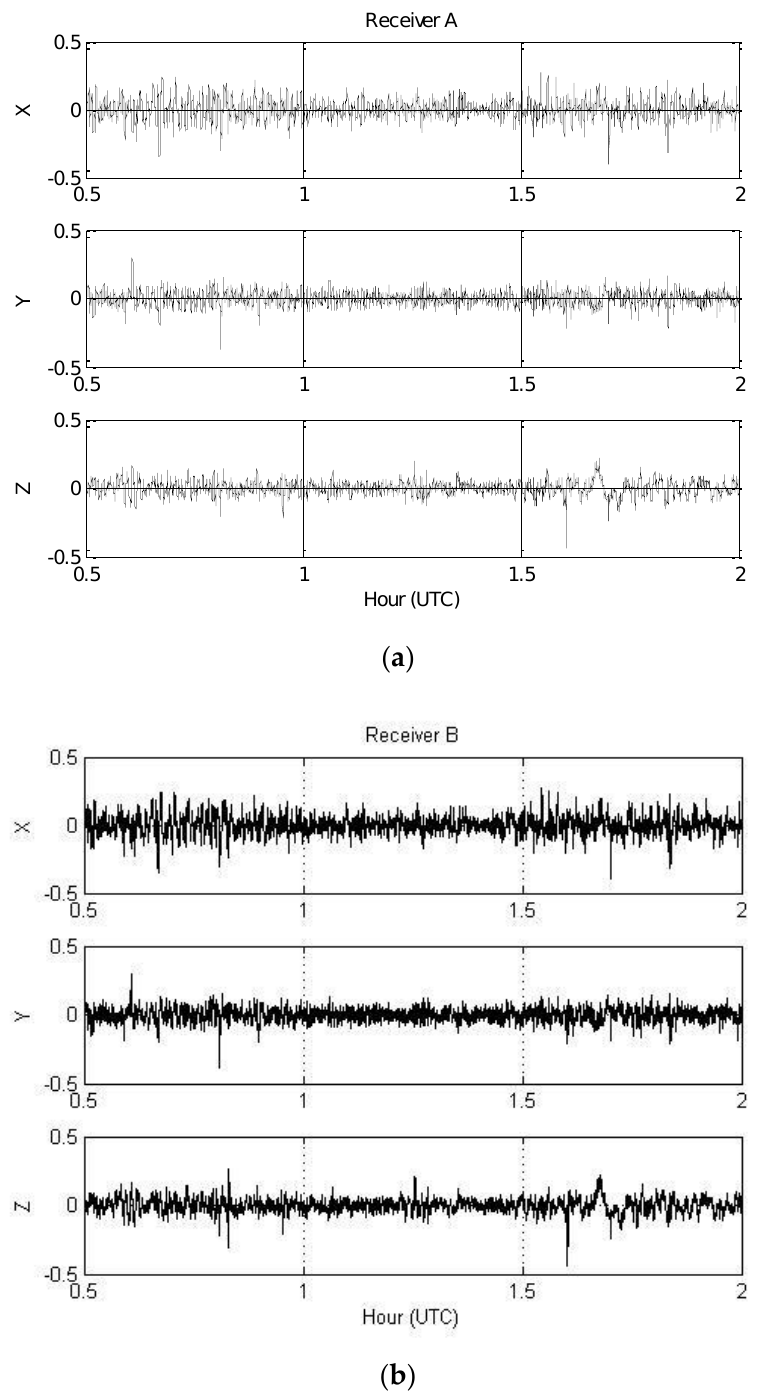
Figure 7. Wavenumber correlation filter (WCF) kinematic accelerations in m/s 2 using the cutoff ε ≥ 0.9: ( a ) Receiver A; ( b ) Receiver B.